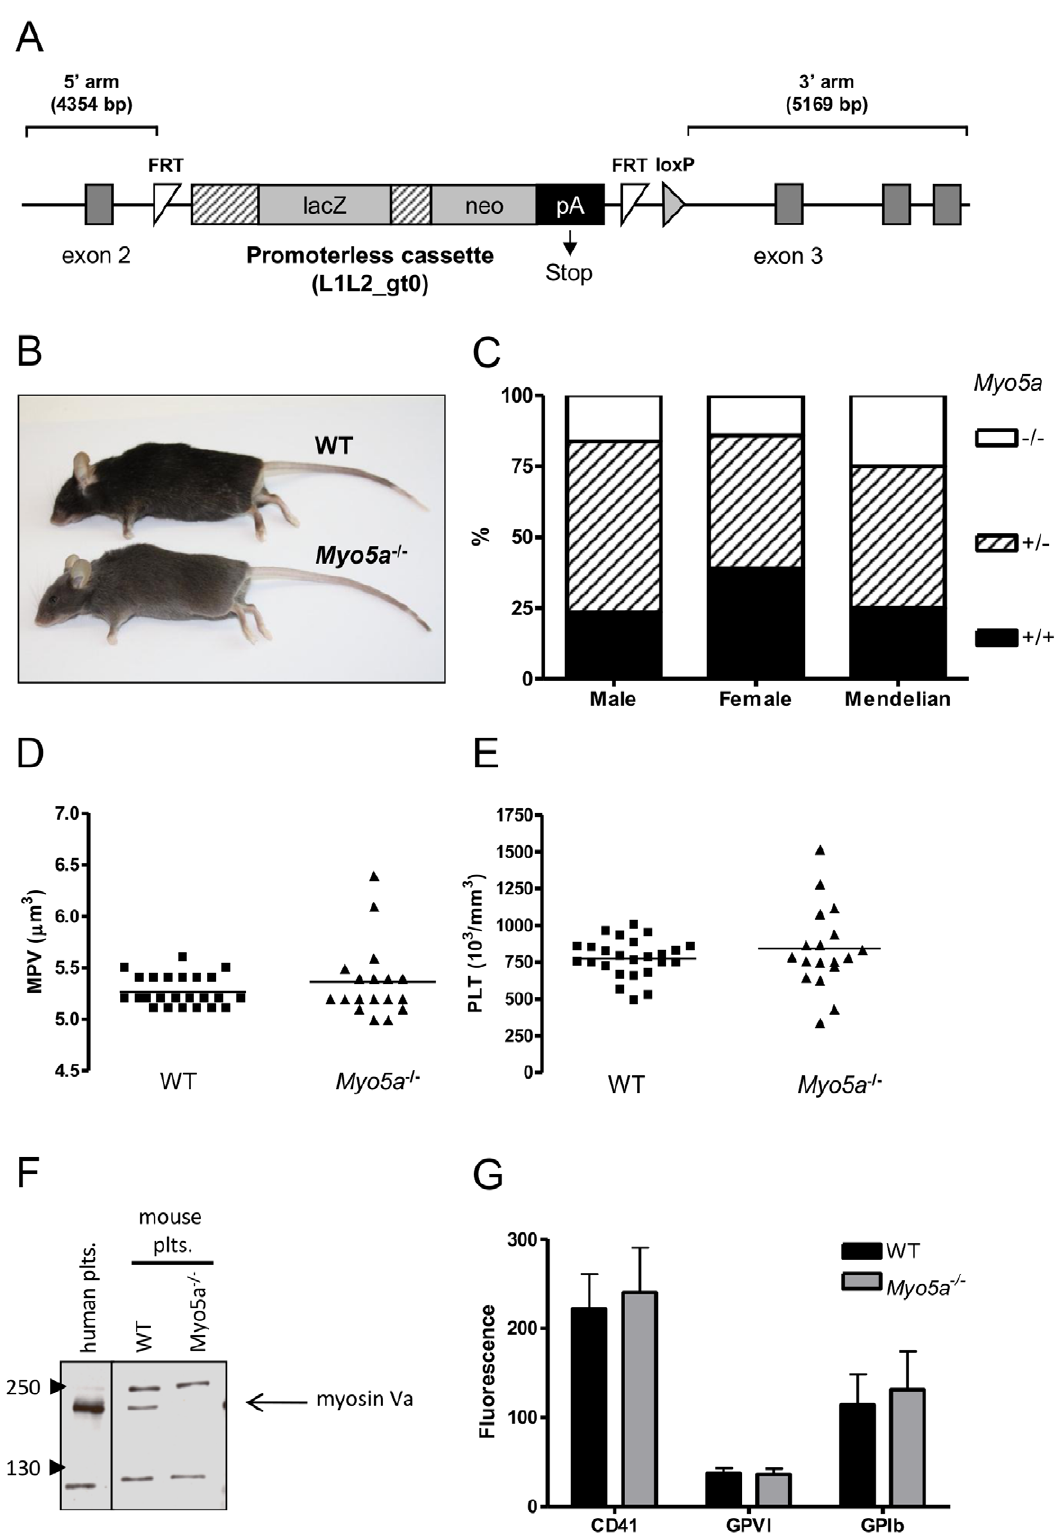
Figure 1. Phenotyping of Myo5a 2 / 2 mice and platelets. (A) Schematic of the targeting vector used to disrupt the Myo5a genomic locus between exons 2 and 3. The cassette contains the lacZ reporter gene, the neomycin (neo) resistance gene, and a polyadenylate (pA) sequence which causes transcription termination. Flp recombination target (FRT) sites are included on either side of the vector along with a loxP site at the 3 9 end. In (B), the difference in coat pigmentation of Myo5a 2 / 2 mice compared to wild-type (WT) is shown. (C) Offspring ratios of knockouts ( 2 / 2 ), heterozygotes ( + / 2 ) and wild-types ( + / + ) from heterozygote breeding pairs were compared from 162 mice. Blood platelet count (D) and mean